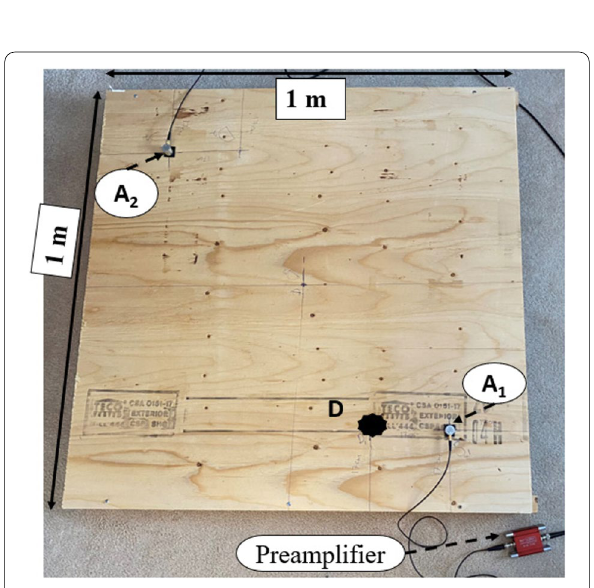
Fig. 17 Experimental setup of the